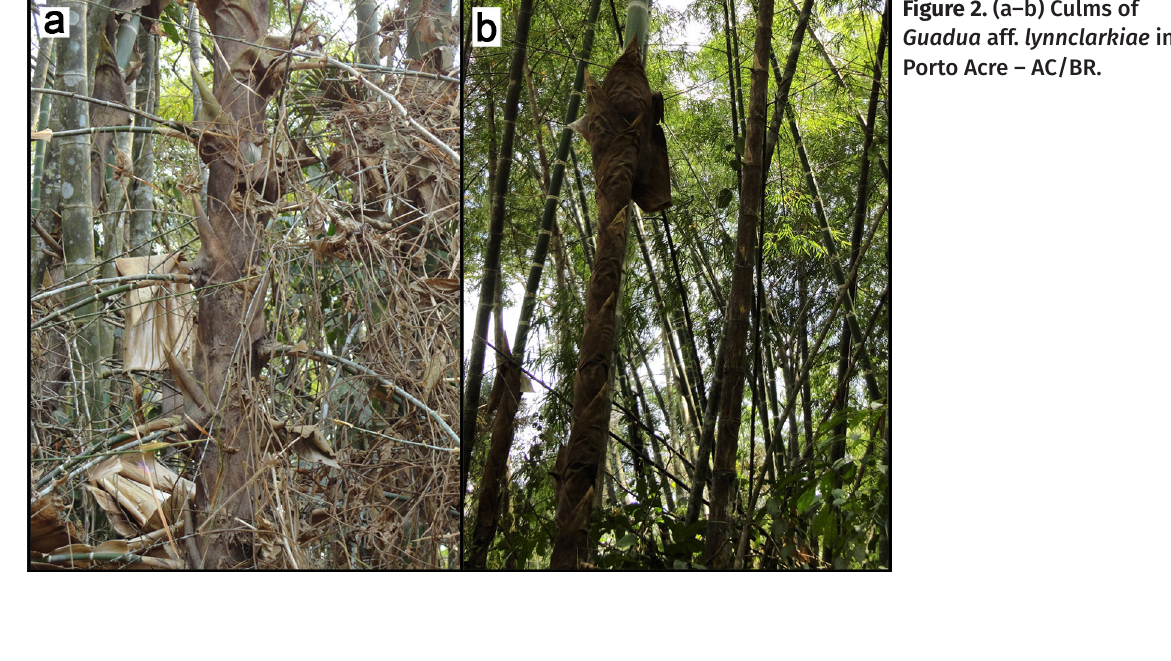
Figure 3. Location of the studied populations in the state of Acre, including the municipalities of Bujari, Sena Madureira and Porto